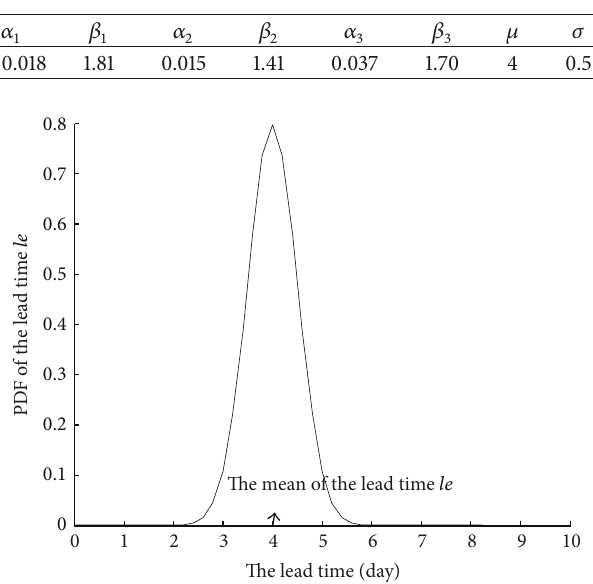
Table 6: Distribution parameters.